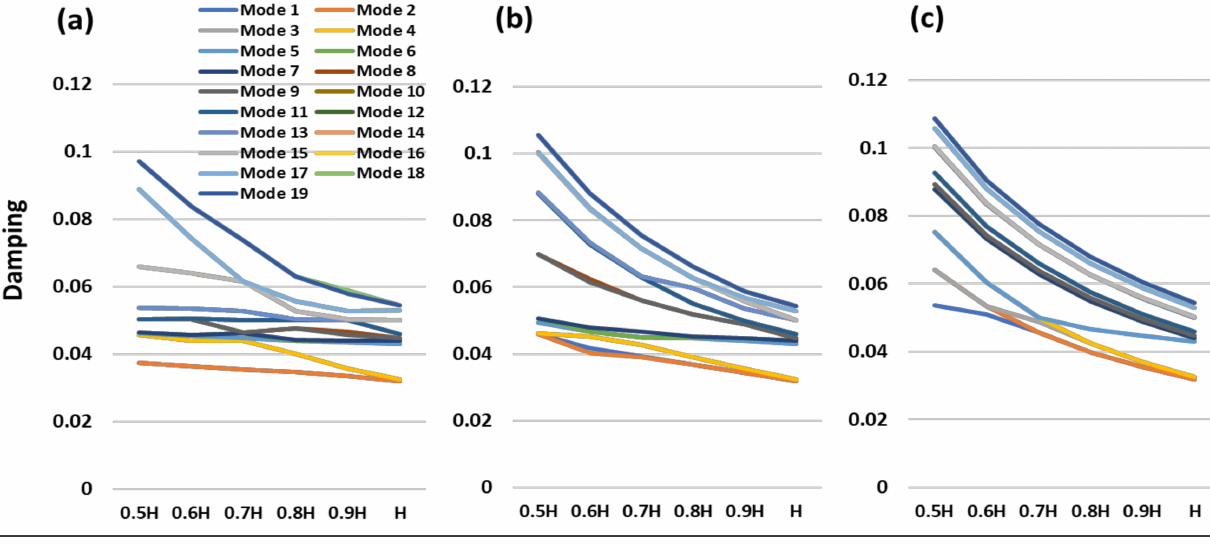
Figure 8. Damping with the increasing order of inertia constant for three scenarios ( a ), ( b ) and ( c